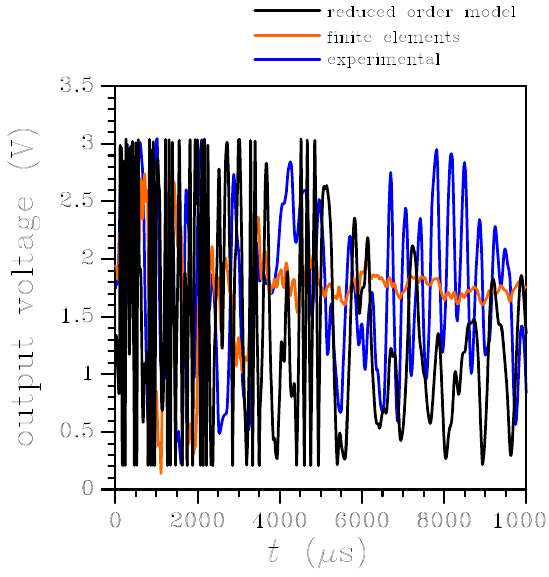
Figure 9. High- g test: time evolution of MEMS output. Comparison between experimental data and numerical results.